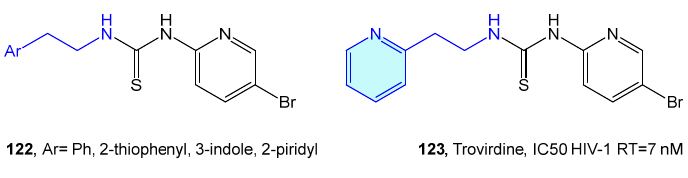
Figure 15. 2-Phenylethyl-based HIV-1 RT receptor ligands.